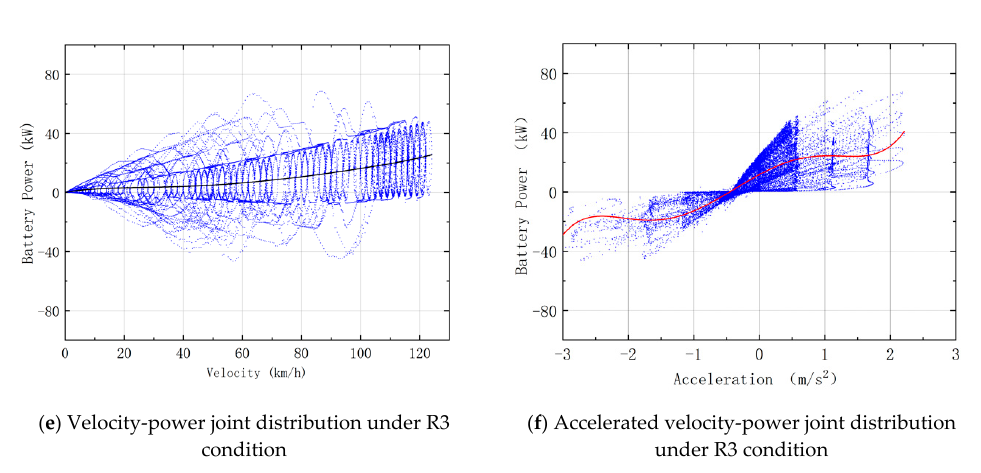
Figure 8. Distribution of BEV velocity and accelerated velocity under different road conditions.